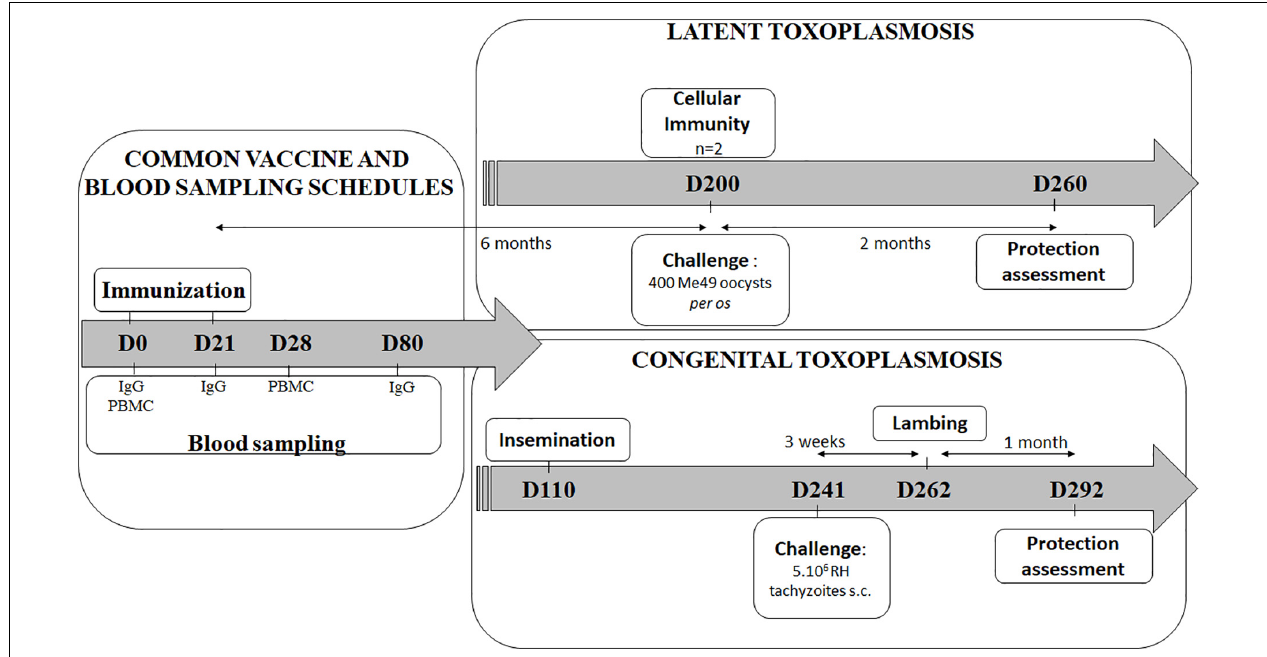
FIGURE 1 | Vaccination and challenge overview of the latent and the congenital experiments. Experiment day are indicated as numbers (D0-D292). The vaccine schedule is common for both experiments (left): two immunizations 21 days apart (D0, D21), blood sampling for IgG detection by ELISA (D0, D21, and D80), and for PBMC (peripheral blood mononuclear cells) collection for antigen recall assay (D0, D28). In latent experiment (upper right): 6 months after vaccination (D200), spleen and lymph nodes from 2 sheep were used for cellular immune response study, and remaining animals were per os challenged then sacrifice 2 months for brain parasitic load counting. In congenital experiment (lower right): sheep were artificially inseminated 3 months after immunizations (D110), then s.c. challenge (D241) was performed 3 weeks before lambing while protection was evaluated 1 month after lambing by determining the sheep and lamb brain cyst load